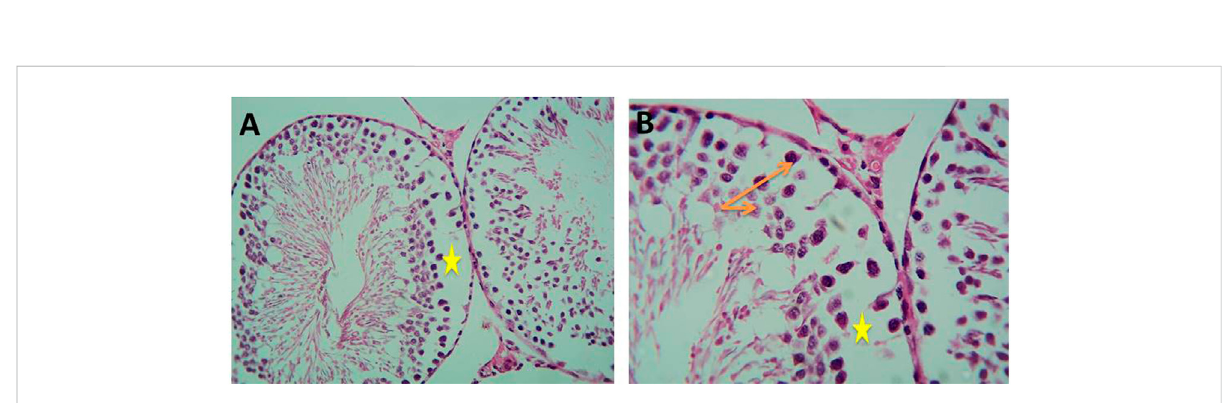
FIGURE 11 Micrograph of Cd-treated albino rats showing decreased thickness of germ cell layer (orange arrows) and detached cells with wide spaces between them (yellow stars) (H&E; (A) -X200, (B) -X400).